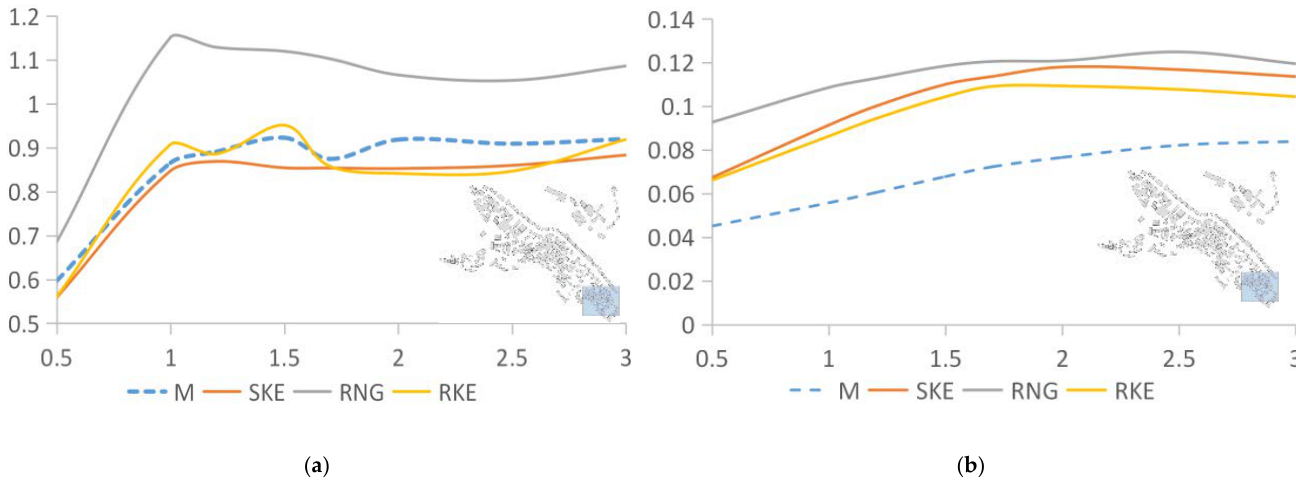
Figure 8. Analysis of measured and simulated data of SKE, RNG, and RKE in an area with a building density of 35.59%. ( a ) Wind speed comparison between SKE, RNG, RKE, and measured data. ( b ) Comparison of turbulence intensity between SKE, RNG, RKE, and measured data.